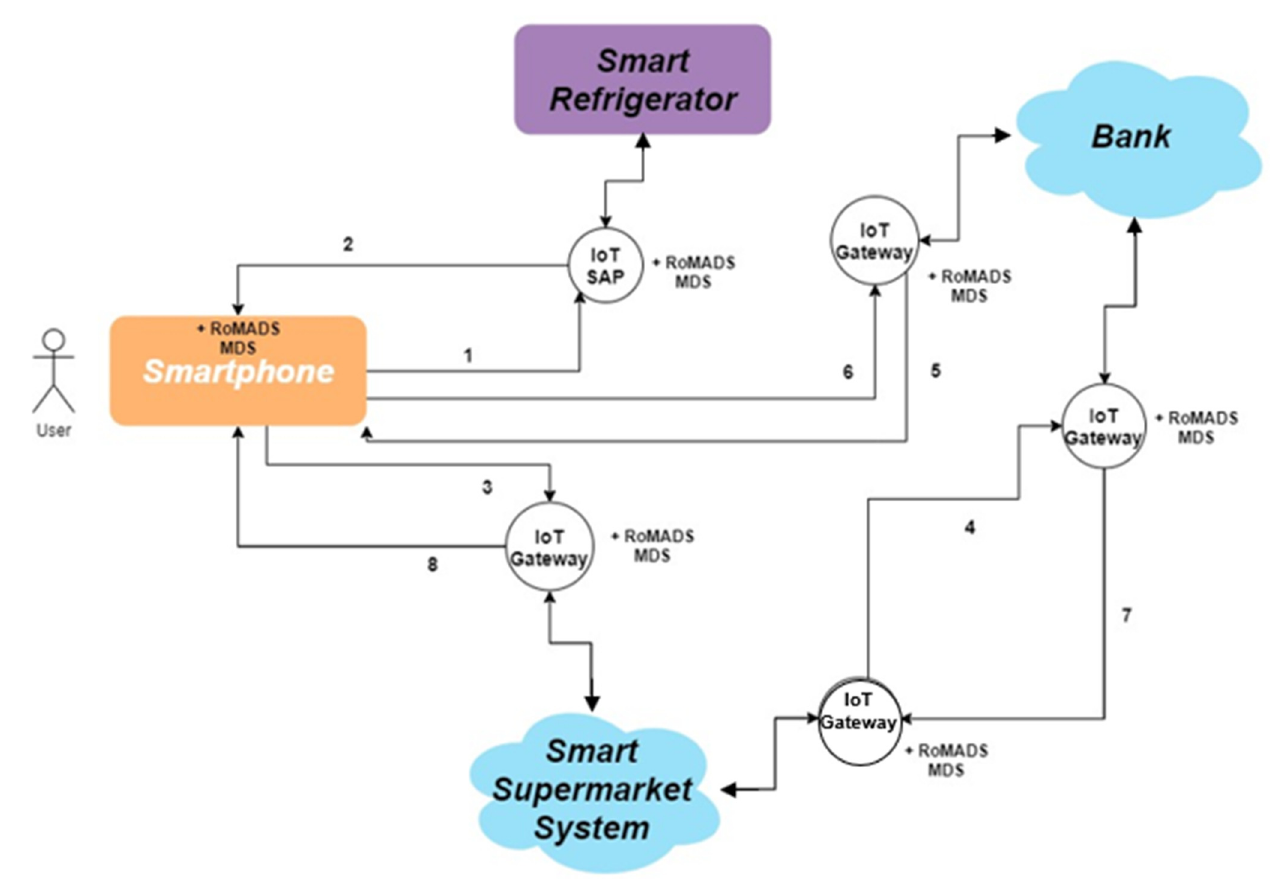
Figure 21. Objects connection diagram.